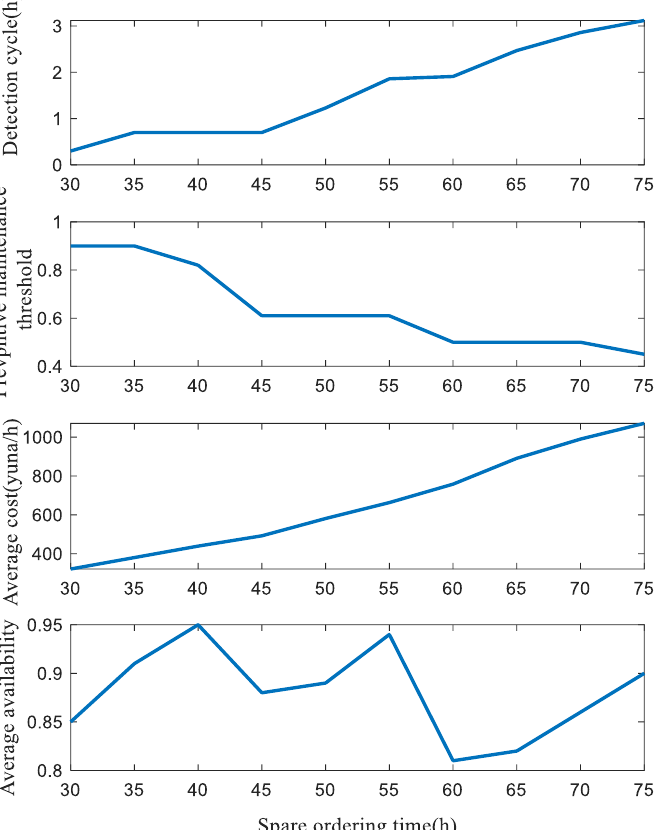
Figure 13. Relationship between spare order time and decision variables, decision criterion .